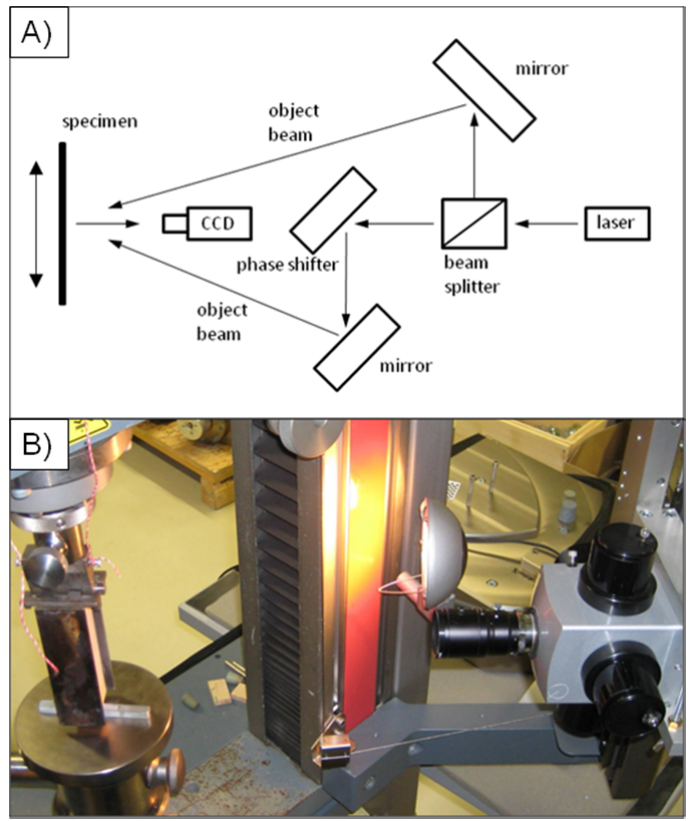
Figure 2. Schematic drawing of the Michelson interferometer ( a ) and electronic speckle pattern interferometry (ESPI) optics set-up for wedge splitting in-plane measurements ( b